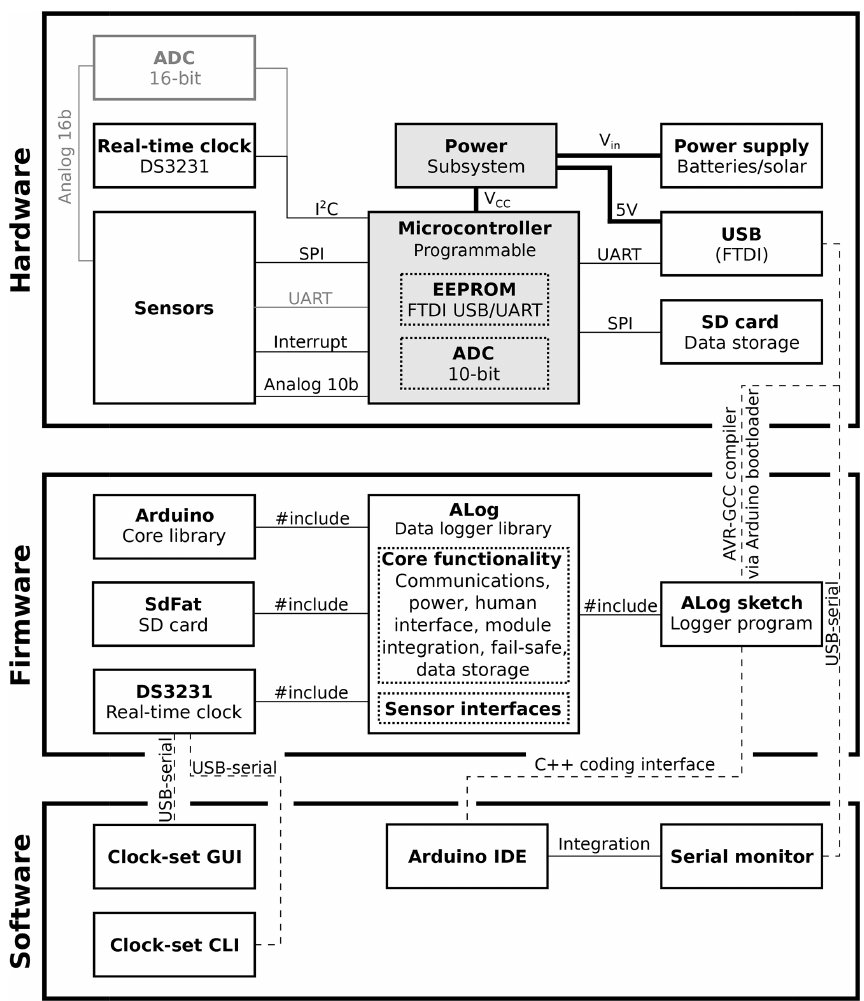
Figure 2. Flowchart of ALog hardware, firmware, and software. “Hardware” includes the generalized subsystems of the physical ALog. “Firmware” includes all of the code that runs on the AVR microcontroller. “Software” runs on the user’s computer. Dashed lines indicate temporary connections (e.g., during programming), whereas solid lines indicate permanent connections and dependencies. Dotted lines within boxes contain information on components of larger systems. Lines in gray indicate features that are included only on the BottleLogger 3.0; gray-shaded boxes denote features that are incorporated into the BottleLogger designs but for the ALog Shield are supplied by a standard Arduino. ADC: analog–digital converter; EEPROM: nonvolatile variable memory that holds values after a power reset; I 2 C, SPI, UART, interrupt, analog: communications protocols; GUI: graphical user interface; CLI: command-line